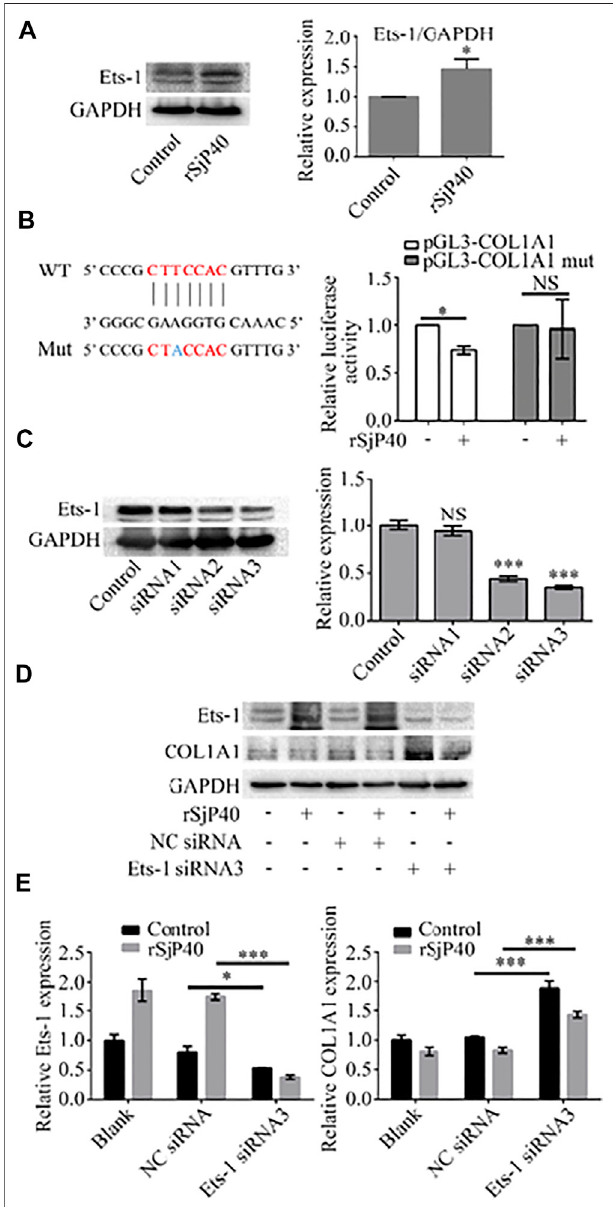
FIGURE 4 | rSjP40 inhibited the expression of COL1A1 via Ets-1. (A) rSjP40 could enhance the expression of Ets-1 protein in LX-2 cells. * p < 0.05, compared to control group. (B) Diagram of SP1-binding site in the COL1A1 promoter region -1,679/-1,673 and Ets-1 binding site mutant was showed (left) . Red represents the ETS-1 binding region and blue represents the mutation site. rSjP40 could inhibit the luciferase activity of COL1A1 promoter(pGL3-COL1A1),but not inhibit theluciferase activity ofthemutated COL1A1 promoter (pGL3-COL1A1 mut) (right) . NSP > 0.05, compared to control group with no rSjP40 stimulation. (C) siRNA NC or siRNA Ets-1 was transfected into LX-2 cells. The downregulated Ets-1 was con fi rmed by western blot 72 h post transfection. (D) Western blot results showed that a higher level of COL1A1 in siRNA Ets-1 cells than that in the siRNA NC group. (E) Quanti fi cationofwesternblotdataforEts-1andCOL1A1inLX-2cells.* p < 0.05, p < 0.001 compared to siRNA NC group. WT, wild type; Mut, mutant; NS, no signi fi cant; NC: Negative